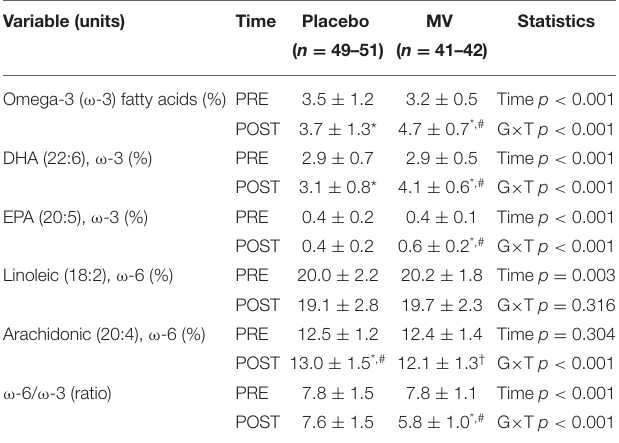
TABLE 3 | Pre- and post-trial red blood cell fatty acid